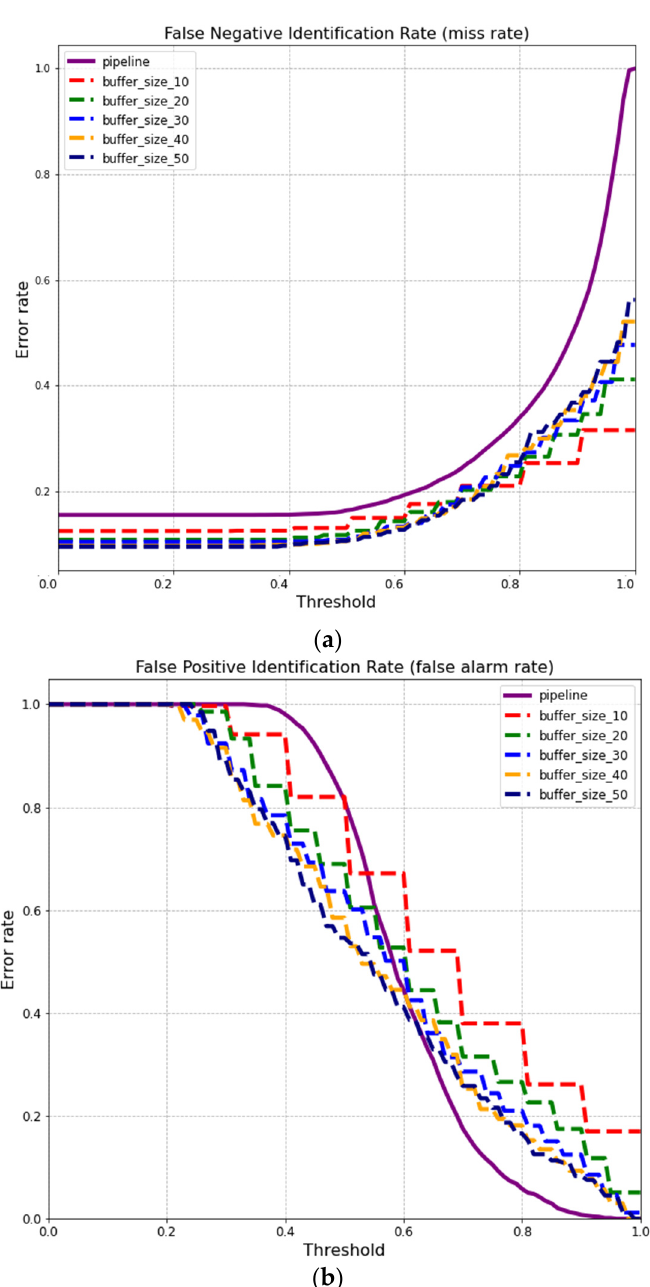
Figure 12. Comparison of detection error trade-off characteristic lines between various buffer sizes and pipeline settings for the ( a ) false negative rate and ( b ) false positive rate.